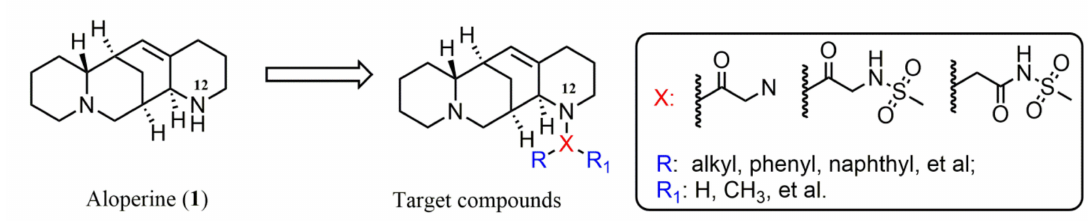
Figure 1. Chemical structure of aloperine and the modification